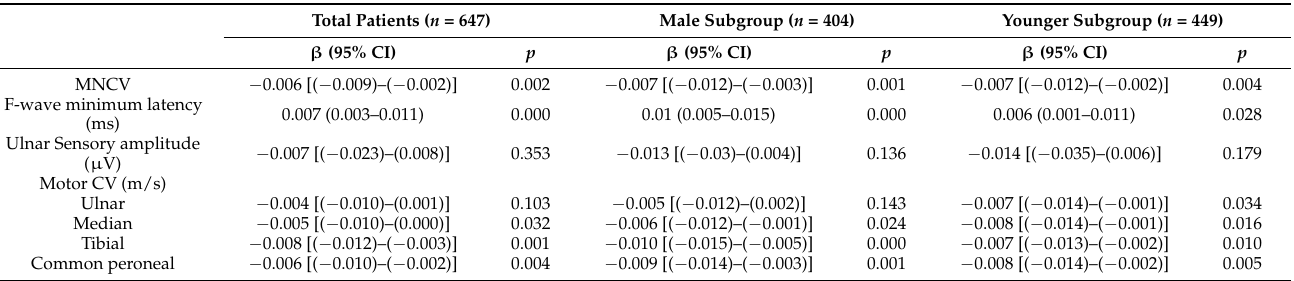
Table 6. Multivariate linear regression analysis of the relationship between serum uric acid and nerve conduction